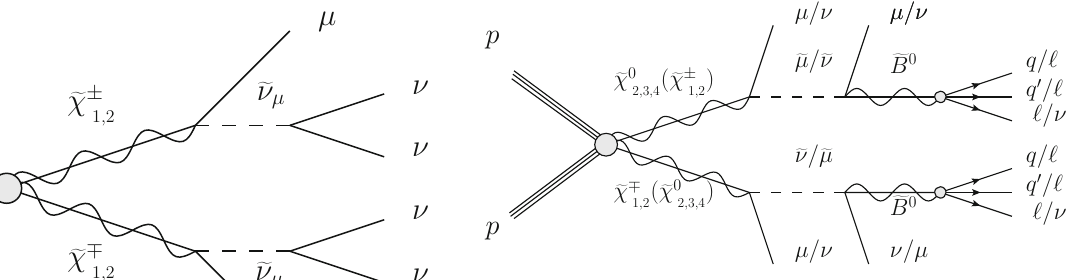
Fig. 11 Production of chargino–neutralino pair decaying to left muon- sneutrino, which in turn decays to a long-lived Bino giving rise to a displaced